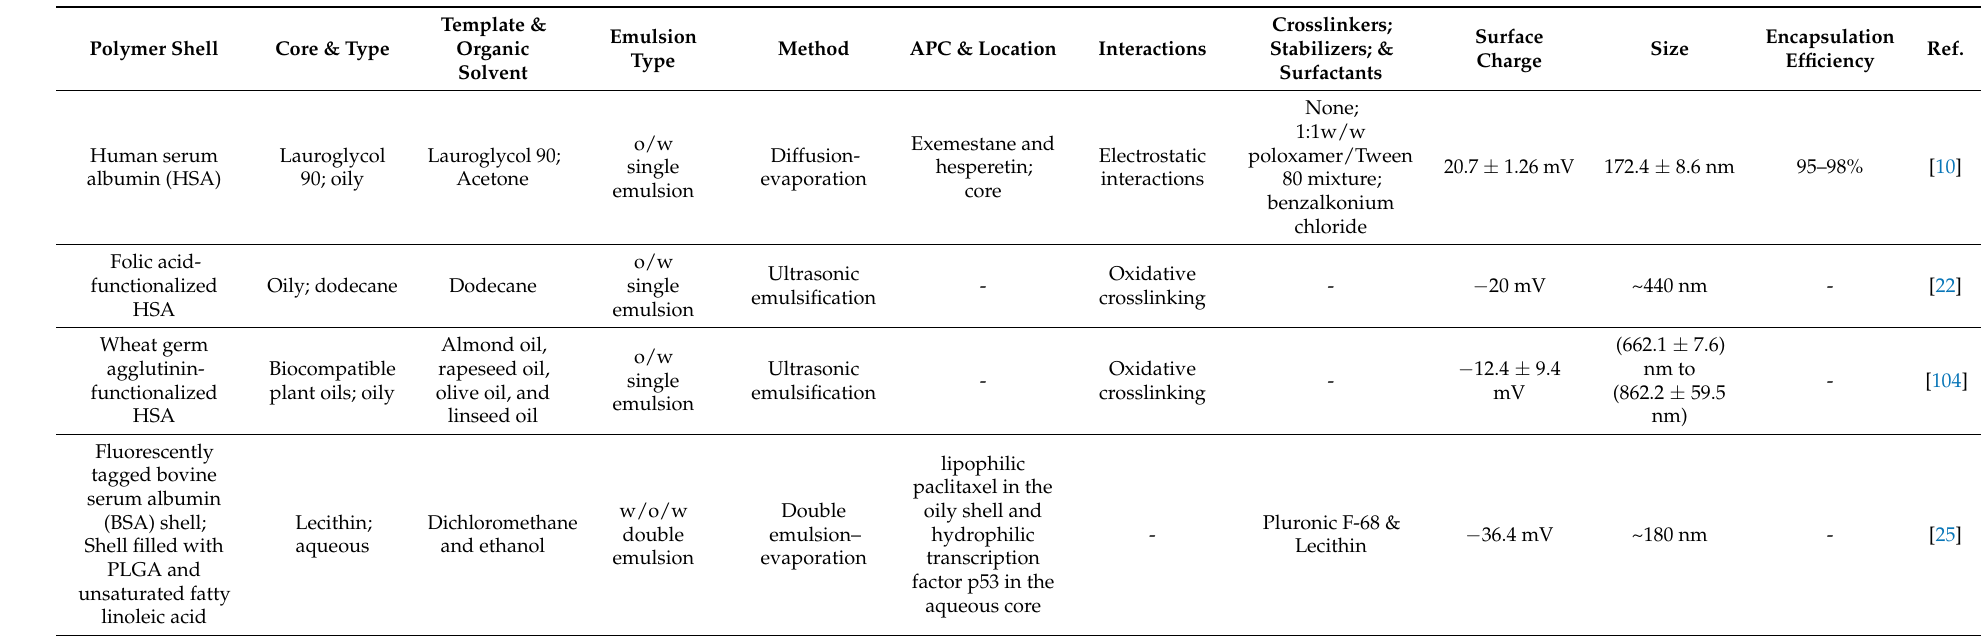
Table 4. Examples of capsules prepared by emulsion templating